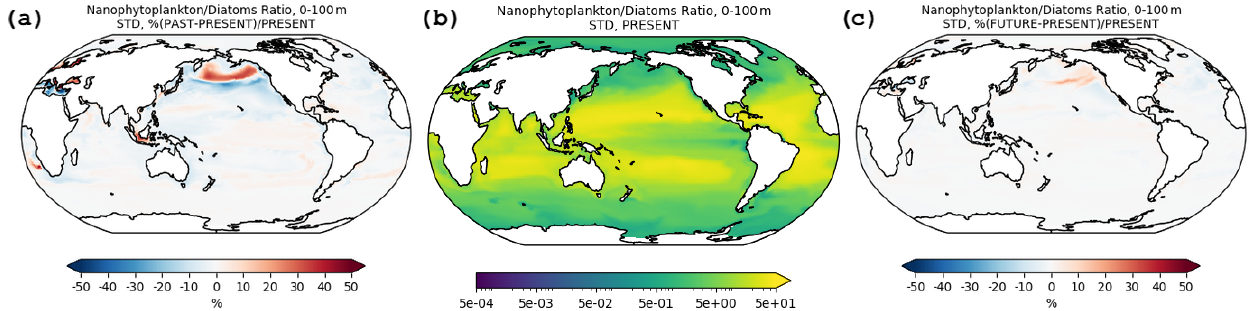
Figure 6. The oceanic concentration ratio of nanophytoplankton to diatoms averaged in the upper 100m for PRESENT (b) for the STD simulation, and the relative changes compared to PAST (a) and FUTURE (c) .